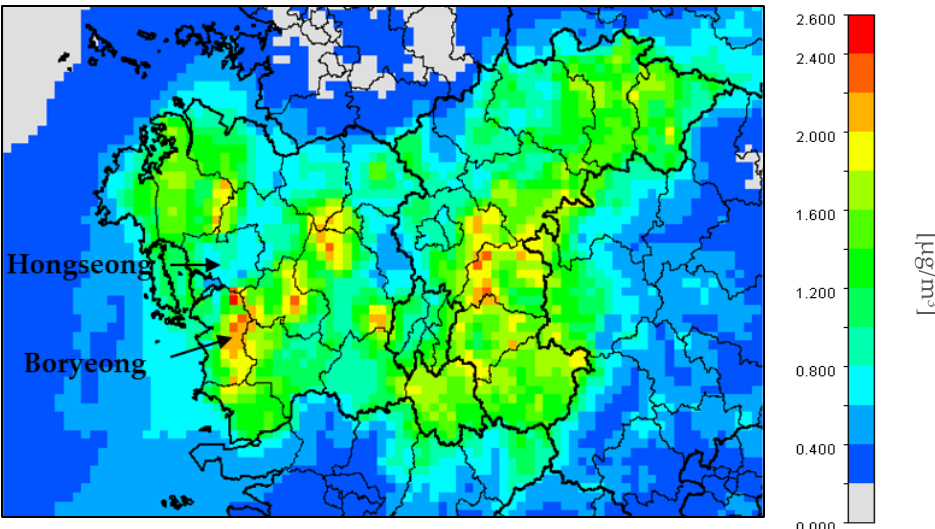
Figure 10. Monthly mean improvement of NH 3 concentration under S1 .